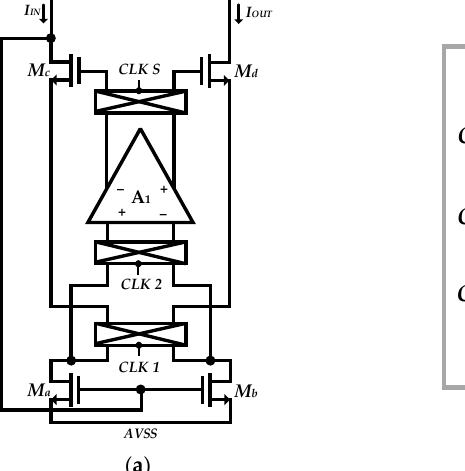
Figure 5. Operation principles of chopper and DEM technique.